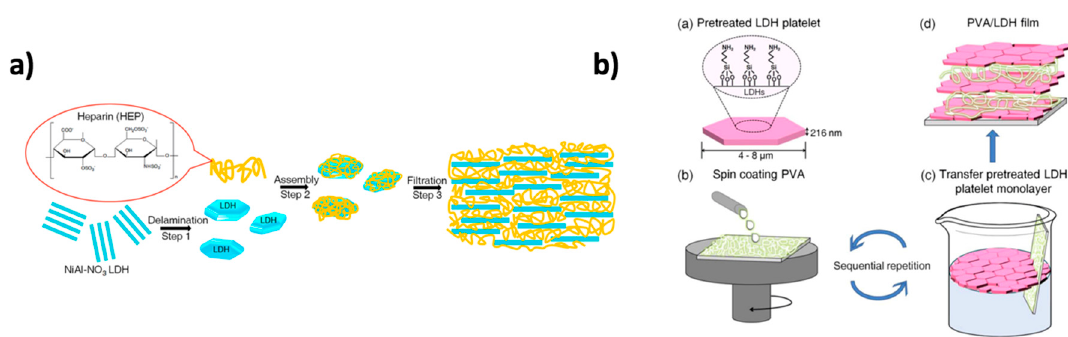
Figure 8. ( a ) Fabrication of the artificial nacre-like HEP/LDH film by three steps: (i) LDH delamination; (ii) assembly of exfoliated LDHs and HEP; and (iii) HEP-LDH hybrid building blocks are aligned by self-assembly induced by vacuum filtration. Reproduced with permission from Ref. [124]. Copyright year (2014) American Chemical Society. ( b ) Fabrication of artificial multilayered PVA/LDH hybrid films by: (i) modification of the surface of LDH platelets with slightly hydrophobic amine-terminated APTES; (ii) spin coating of a layer of PVA; (iii) gradual formation of Langmuir film at the air–water interface; and (iv) sequential repetition to fabricate multilayer films. Reproduced with permission from Ref. [125]. Copyright year (2014) American Chemical Society.